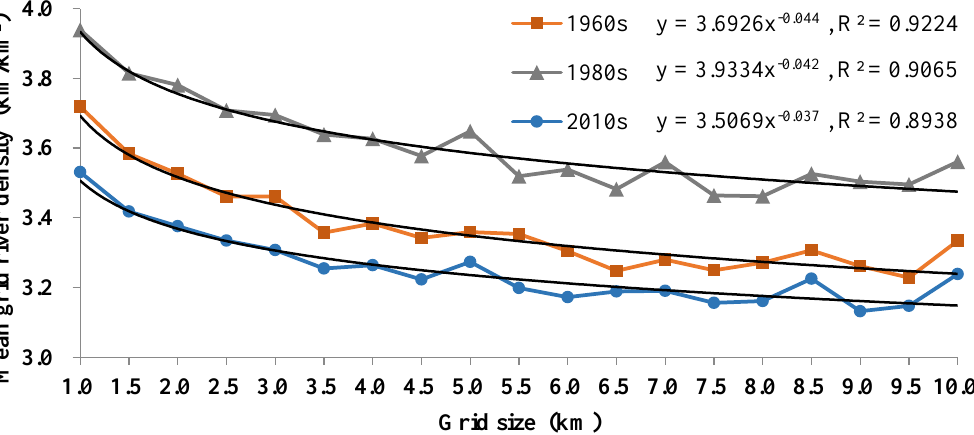
Table 2. Transfer matrix of land use (%). Each cell in the matrix represents how land cover changed between two land use types between 1983 and 2014.